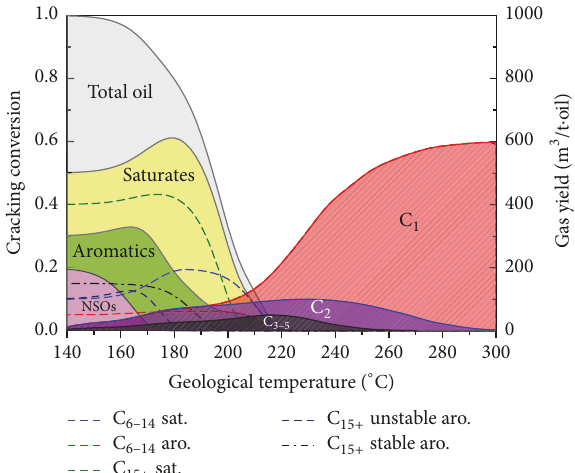
Figure 4: Gas generation model of crude oil and its components (heating rate 2 ∘